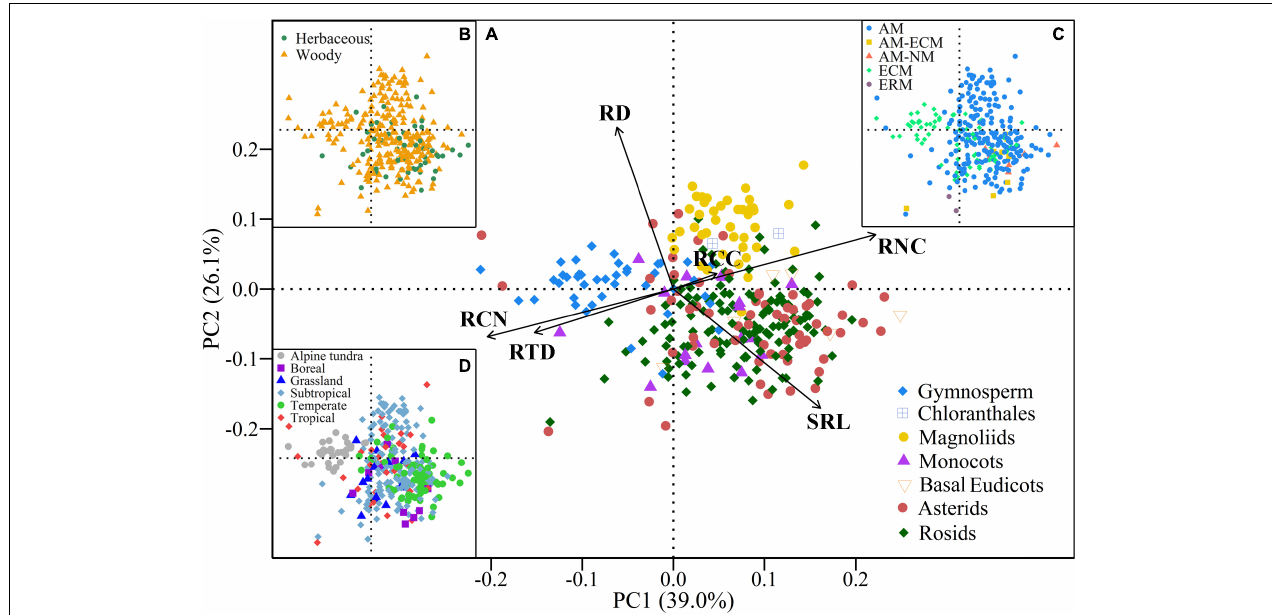
FIGURE 2 | Phylogenetic principal component analysis (pPCA) results of the six root traits for all species. (A–D) pPCA results for all species coded by phylogenetic clades, plant growth forms, mycorrhizal types, and biomes, respectively. RD, root diameter; SRL, specific root length; RTD, root tissue density; RCC, root C content; RNC, root N content; RCN, root C:N ratio; AM, arbuscular mycorrhizal; ECM, ectomycorrhizal; ERM, ericoid mycorrhizal; NM, non-mycorrhizal.